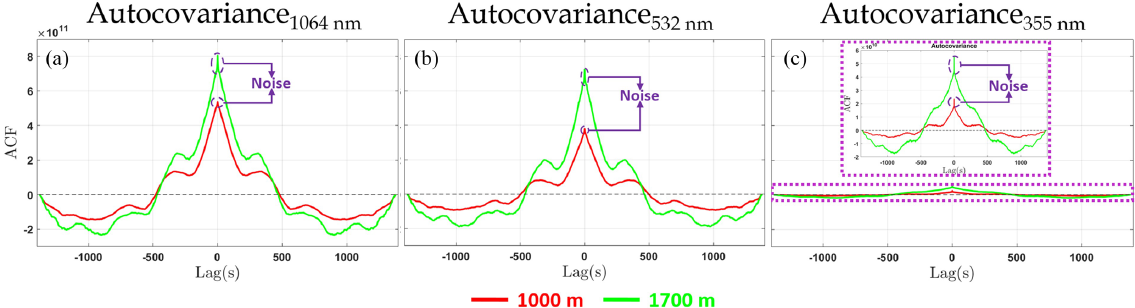
Figure 5. Autocovariance function at 1064nm (a) , 532nm (b) and 355nm (c) on 26 July 2017 from 17:00 to 18:00UTC. For 355nm the insert magnifies the signal